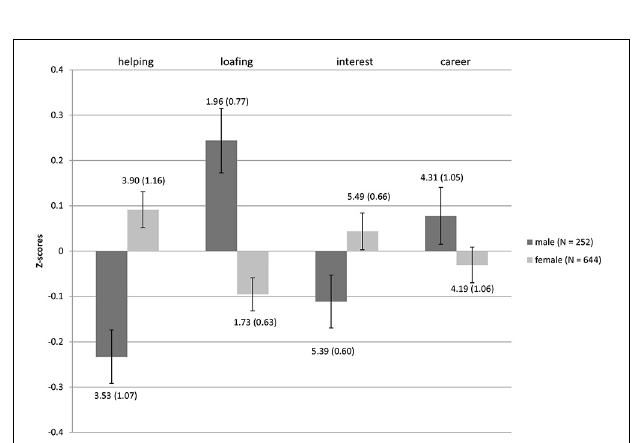
FIGURE 3 | Differences in MICC motivations between genders for Sample 1. Bars represent the mean standardized scores and error bars represent the standard error of the mean. Values represent the means with standard deviations in parentheses.